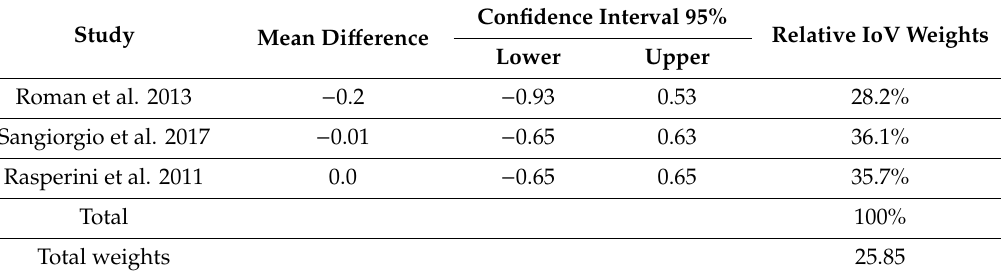
Table 5. Mean Di ff erence and Confidence Interval (95%) are expressed in mm.